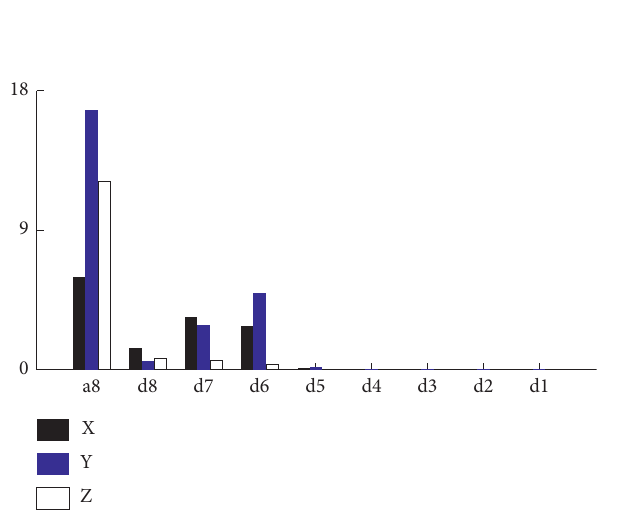
Figure 11: Energy of each frequency bands in different directions (cm/s) 2 .